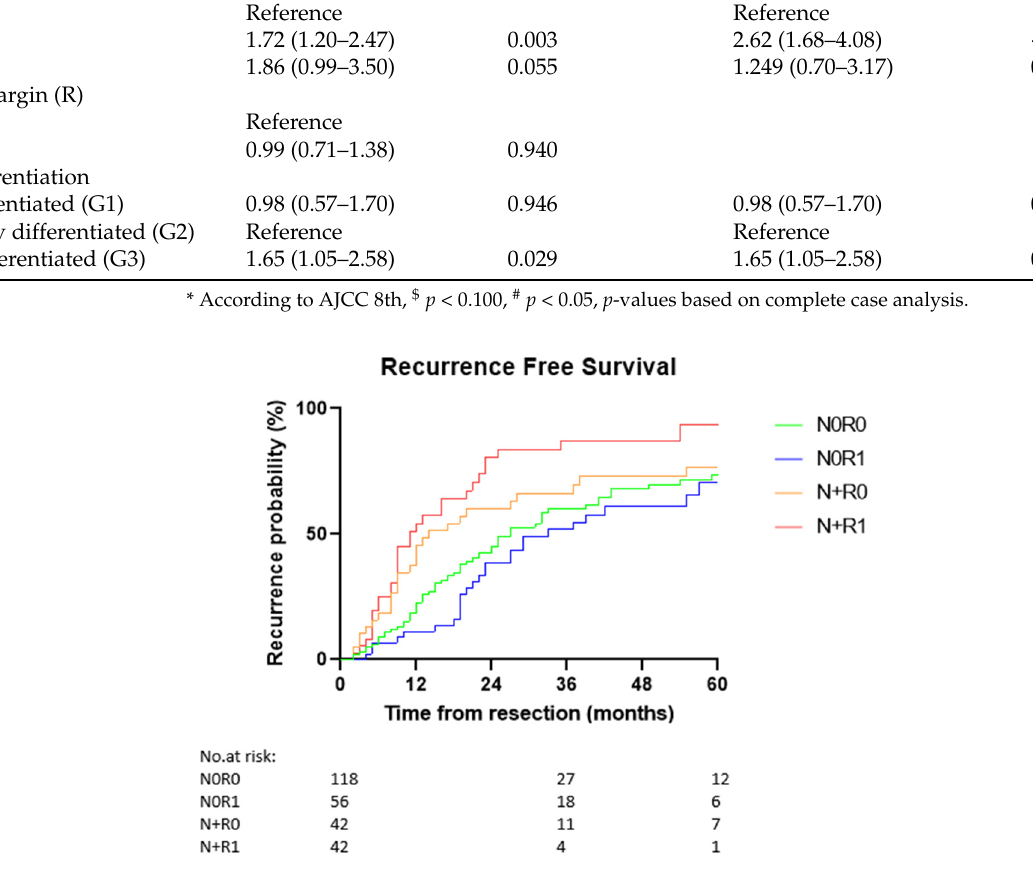
Figure 3. Estimated cumulative recurrence probability of N0R0, N0R1, N+R0, and N+R1 patients. Only the first 5 years are displayed. The median recurrence-free survival was 27 months (95% CI 20.4–33.6) for N0R0, 33 months (95% CI 19.5–46.5) for N0R1, 14 months (95% CI 7.4–20.6) for N+R0, and 11 months (95% CI 5.7–16.3) for the N+R1 patients ( p < 0.001). N0R0 vs. N+R0: p = 0.151, N0R1 vs. N+R1: p < 0.001, N+R0 vs. N+R1: p = 0.109, N0R0 vs. N0R1: p =